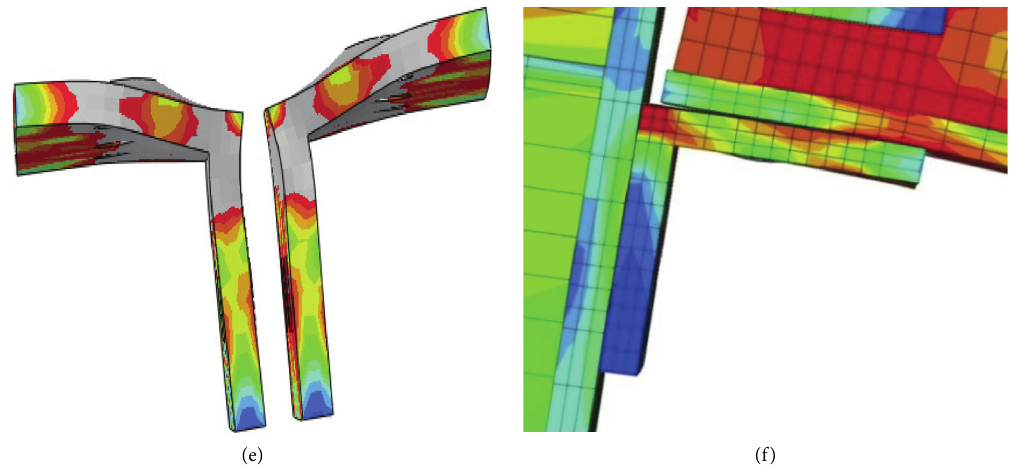
Figure 12: Comparison of ultimate failure states of SJA-3. (a) Overall test deformation. (b) Gusset angle steel test deformation. (c) Seat angle steel test deformation. (d) Finite element deformation. (e) Gusset angle steel finite element deformation. (f) Seat angle steel finite element deformation.